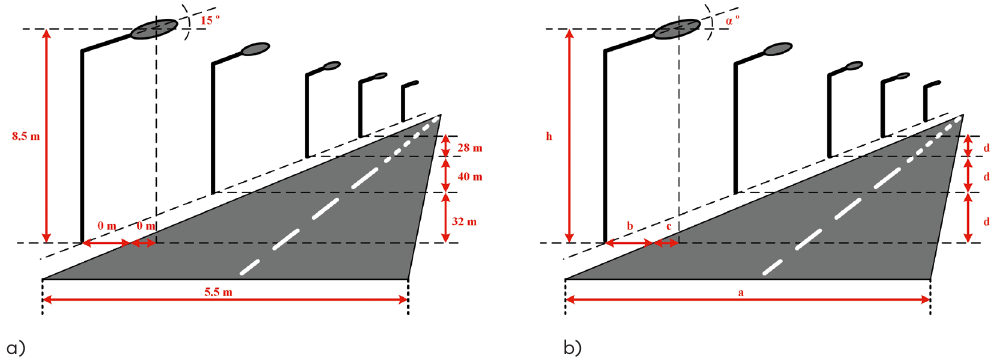
Figure 5. The necessary geometrical input data for Dialux light distribution calculations